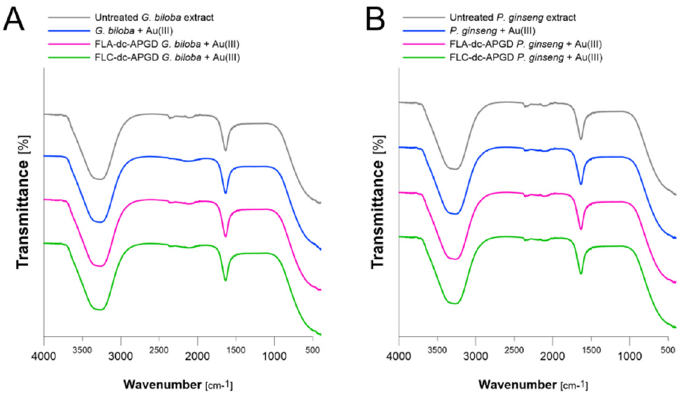
Figure 6. Attenuated total reflectance Fourier transform-infrared spectroscopy (ATR FT-IR) spectra of aqueous ( A ) G. biloba and ( B ) P. ginseng extracts used for the AuNPs synthesis. Table 3. ATR FT-IR bands identified for the prepared aqueous plant extracts.